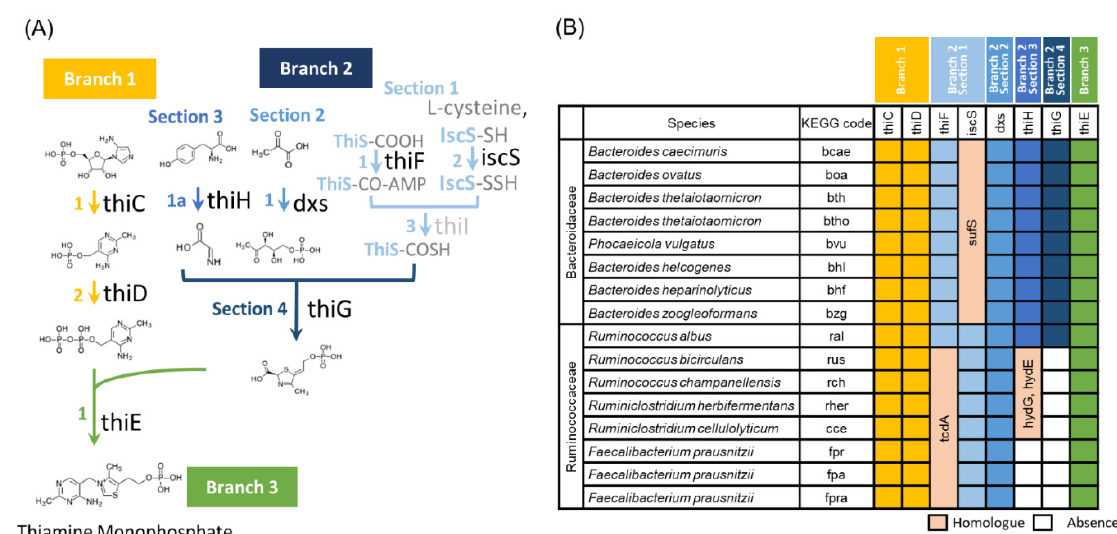
Figure 3. Pathway information and retention ratio for thiamin (vitamin B1) synthesis. ( A ) Pathways involved in vitamin B1 synthesis. ( B ) Retention ratio of specific enzymes in bacteria belonging to the Ruminococcaceae and Bacteroidaceae